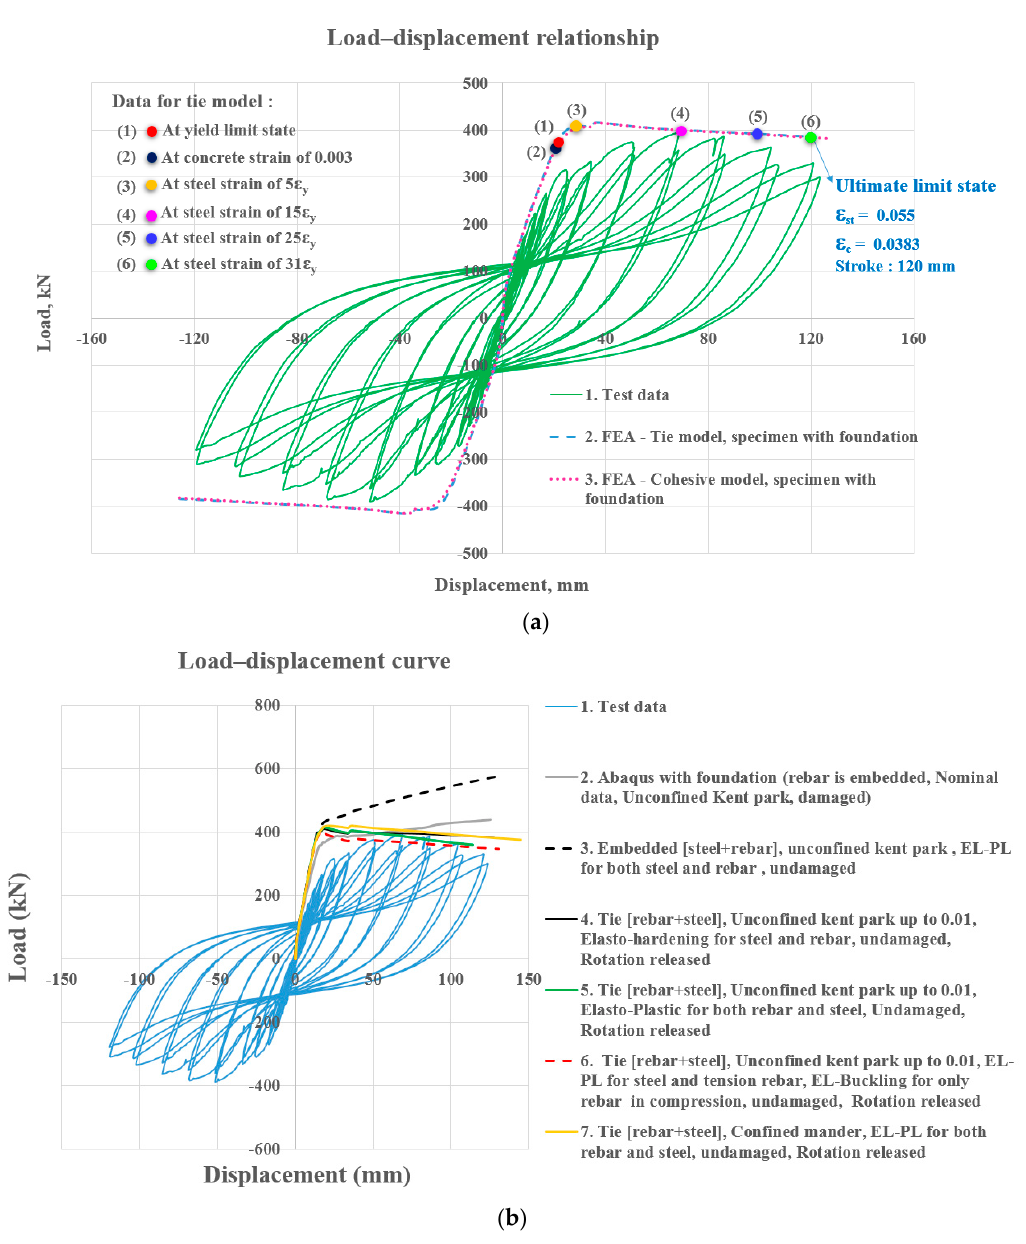
Figure 10. Finite element analysis compared with test data [25] (with base vs. without base): ( a ) With base rotation; test data included base rotation; ( b ) without base rotation (FEA); test data included base rotation.